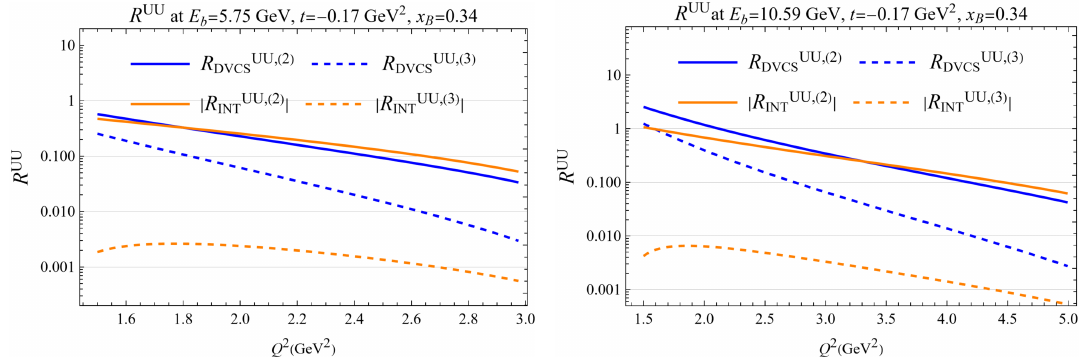
Figure 9 . A comparison of cross-section ratios at JLab 6 GeV (left) and 12 GeV (right) kinematics. The absolute values of them are taken when negative values are encountered. The CFFs in table 1 are used, assuming weak Q 2 -dependence of them. The plots show clearly the suppression of the twist-two (solid lines) and twist-three (dashed lines) contributions relative to the BH background as the Q 2 increases. In addition, it is also apparent that the twist-three effects get suppressed faster, as indicated by their high-twist